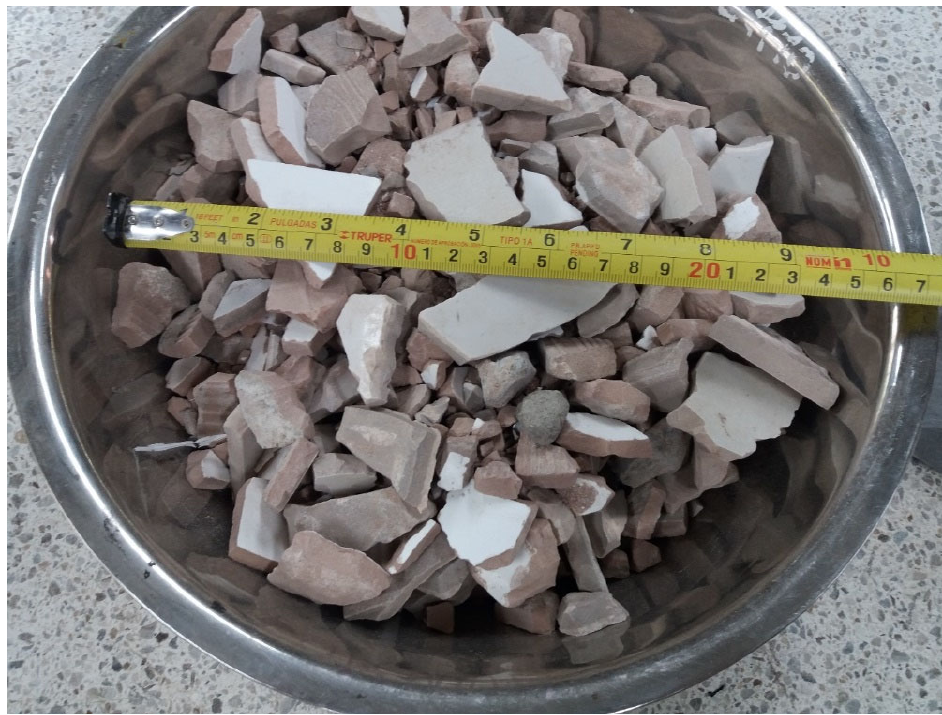
Figure 1. Brick waste (own source).